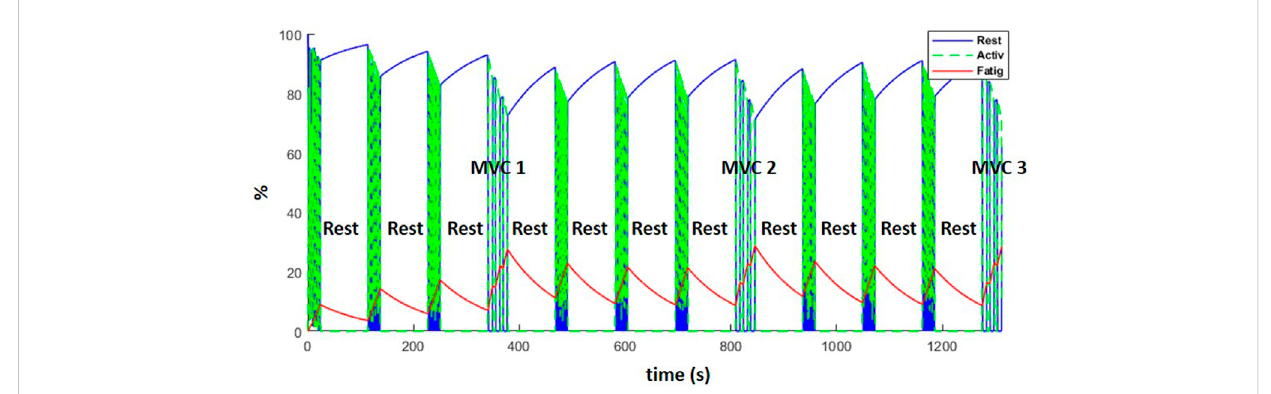
FIGURE 12 Evolutionoftheresting(blue),active(green)andfatigue(red)compartmentsofthebicepslonghead,duringthecompletetrainingsession(including MVCs every fourth set and resting